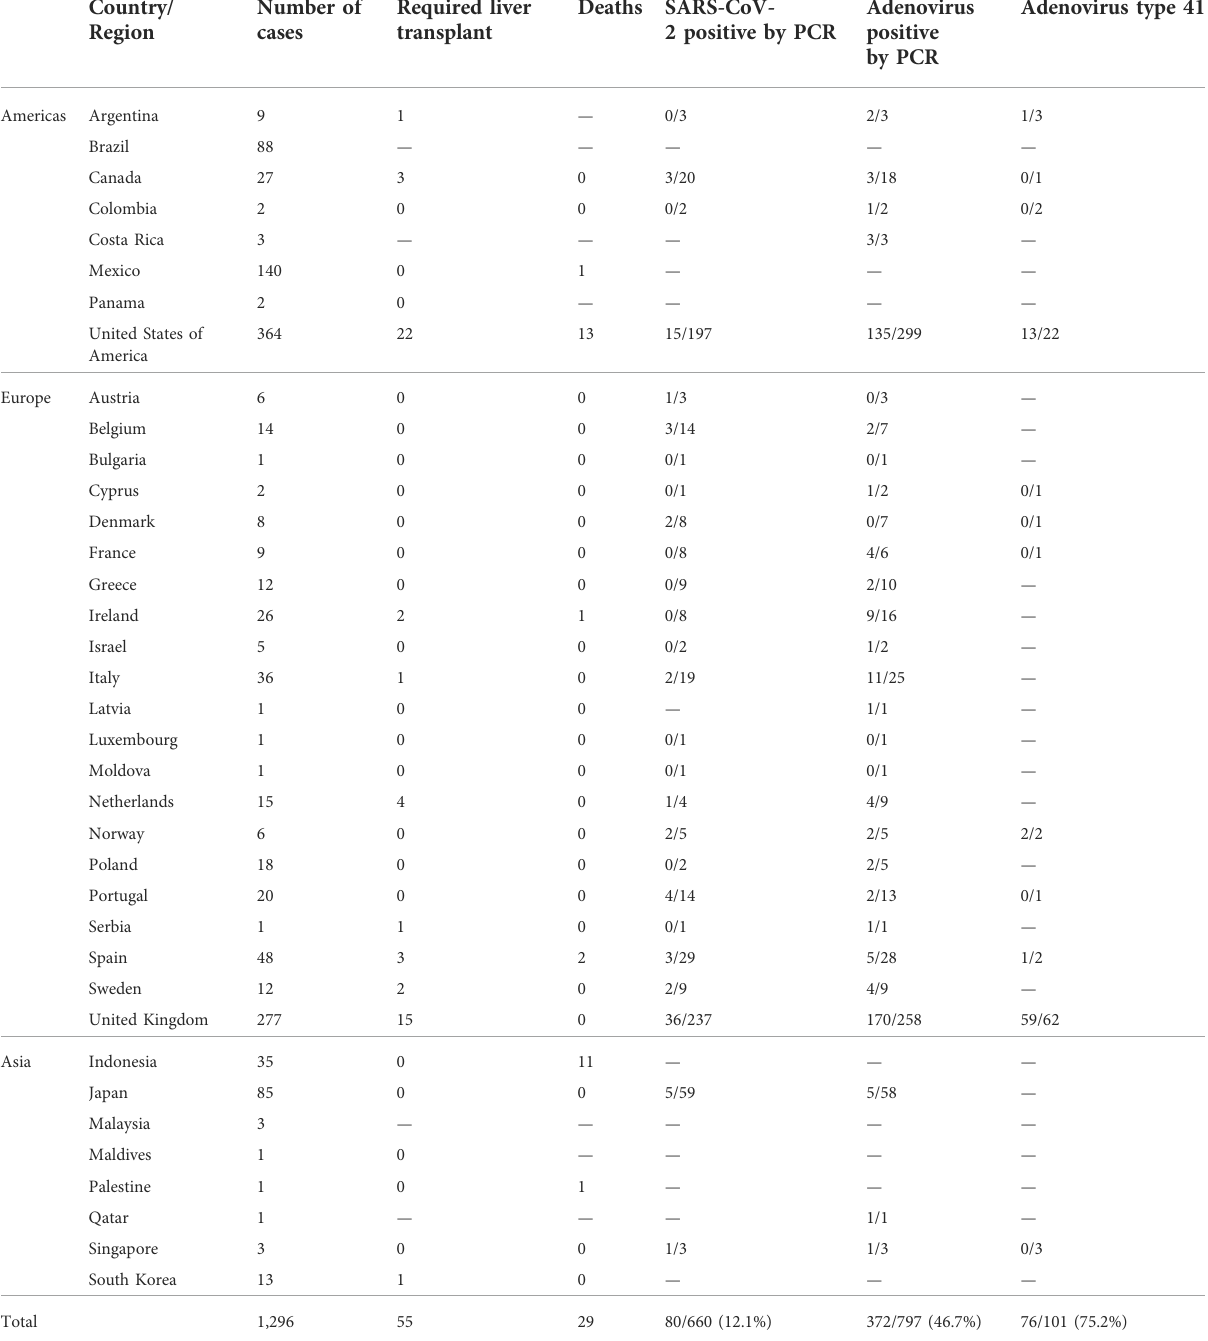
TABLE 1 Summary of possible cases reported by countries/regions as of 14 September 2022. Country/